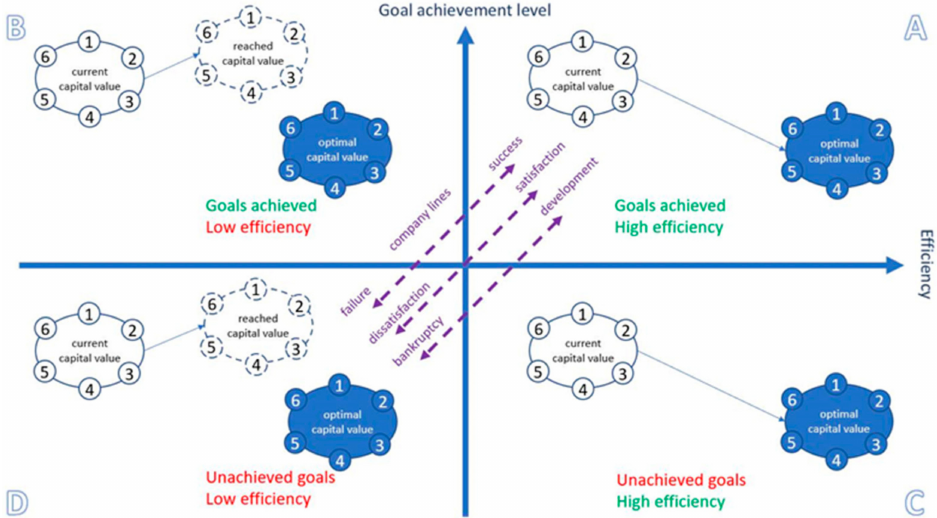
Figure 1. Illustration of the principles of sustainable management of a company’s capital.